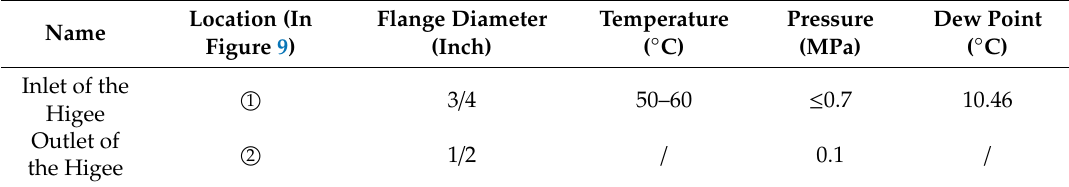
Table 6. The interface parameters of the Higee.